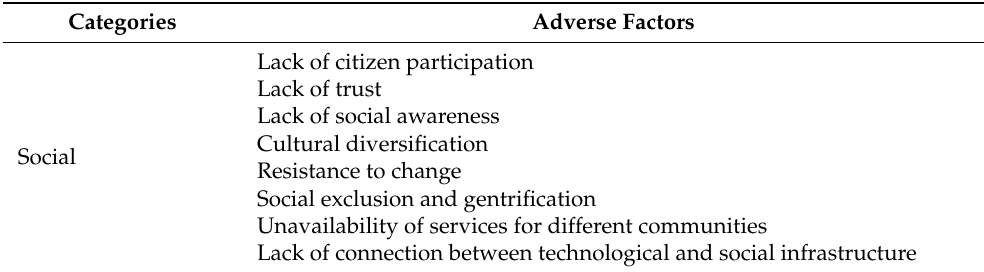
Table 9. A cumulative list of the smart city development barriers [99,118].